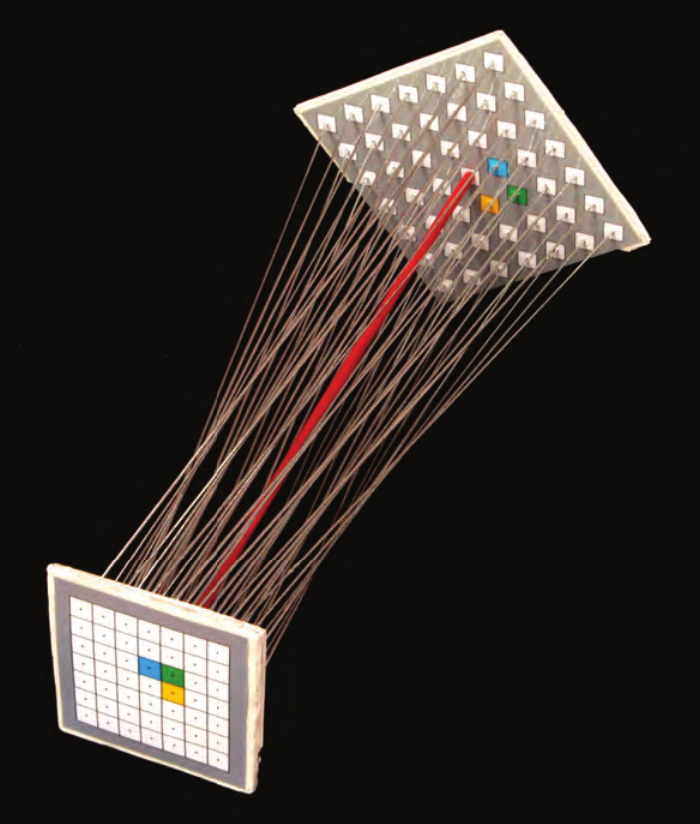
Figure 6 A simple model which shows the rays emerging from the thin lens represented in Figures 3 to 5. The orange rod at the centre represents the optical axis. The pencil of rays twists in a right-handed sense and expands as one travels away from the lens which is located at the lower left. The incident segments of the rays (not shown) are perpendicular to the lens. The deflections have been exaggerated by a factor of about 5 for clarity. The actual deflections would result from a lens of power –5 L D approximately. The model was made by Ms S. Fouché and photographed by C